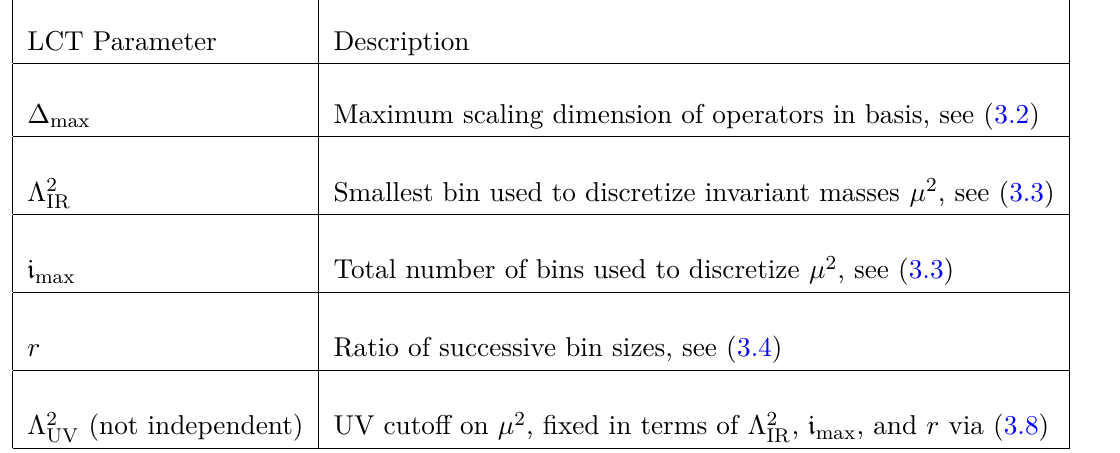
Table 1 . LCT truncation parameters along with their descriptions, specific to our setup of using bins as smearing functions to discretize the continuous invariant masses µ 2 of basis